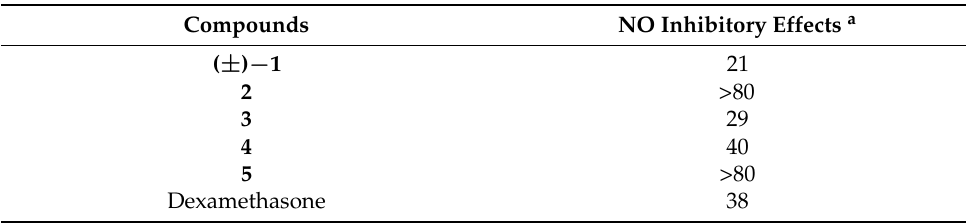
Table 2. Anti-inflammatory effects of compounds 1 – 5 on the production of NO in lipopolysaccharide (LPS)-stimulated RAW264.7